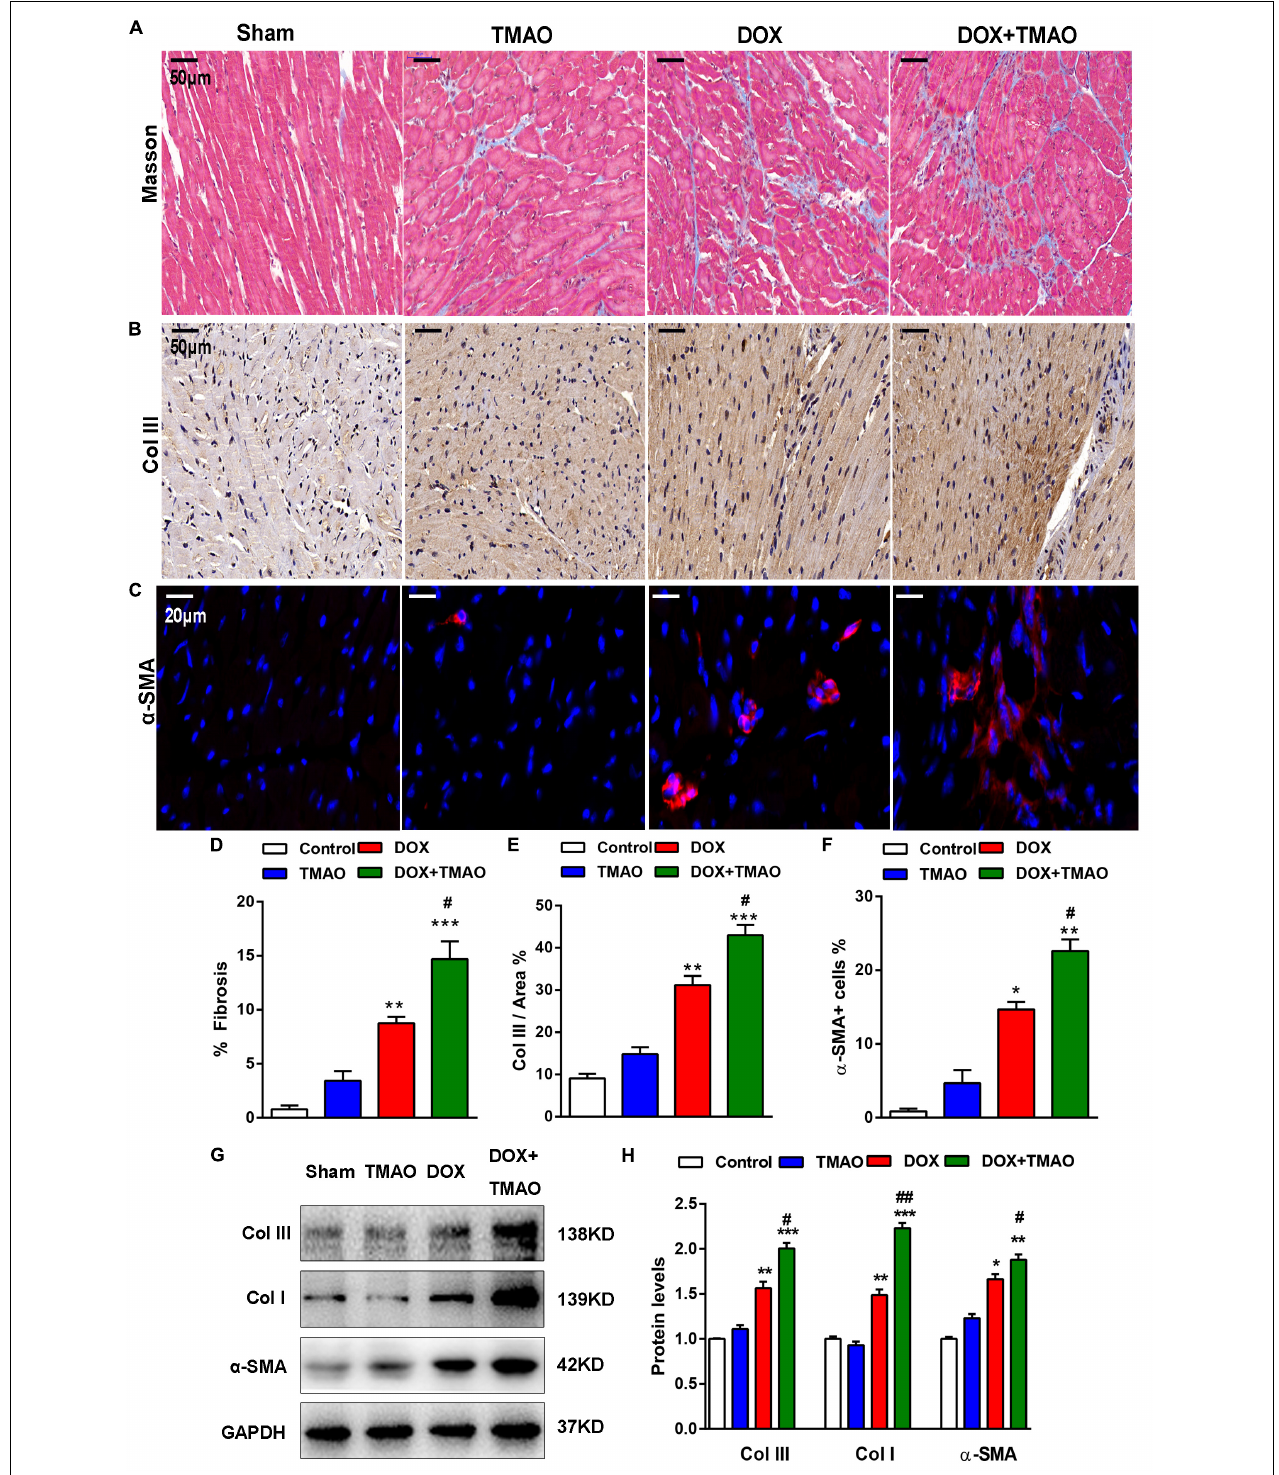
FIGURE 2 | TMAO aggravated doxorubicin-induced cardiac fibrosis in mice. (A) Representative images of Masson’s staining and immunohistochemical staining for collagen type III (Col III) (B) and immunofluorescence staining for α -SMA (red) and DAPI (blue) in cardiac sections (C) . Scale bar = 50 µ m. (D) Quantification of the percentage of fibrosis, Col III area (E) and α -SMA-positive cells (F) . (G,H) Collagen I (Col I), Col III, and α -SMA protein expression levels were analyzed by western blotting and quantified according to immunoblotting (the ratio of protein pixel density/GAPDH pixel density). All data were analyzed at least three times. Mean ± SD. ∗ P < 0.05, ∗∗ P < 0.01, ∗∗∗ P < 0.001 (vs. Control). # P < 0.05, ## P < 0.01 (vs. DOX).